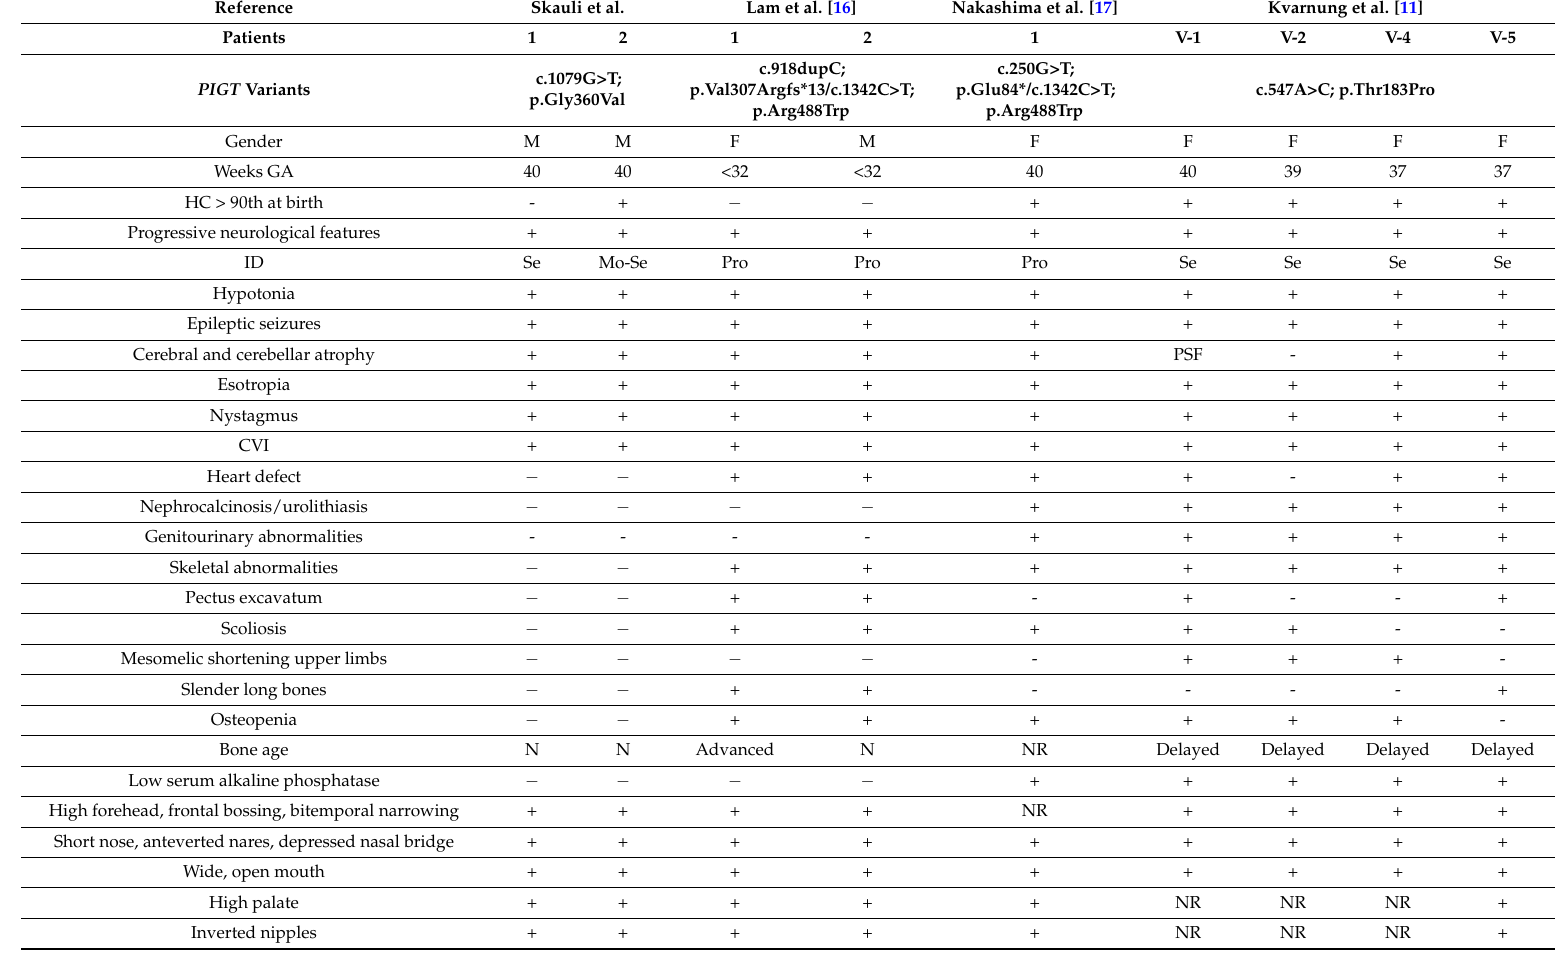
Table 1. Summary of the main clinical features in the patients with Multiple Congenital Anomalies-Hypotonia Seizures Syndrome 3 (MCAHS3) reported to date. +, clinical feature present; − , clinical feature absent. Abbreviations: CVI, cortical visual impairment; ID, intellectual disability; F, female; GA, gestational age; HC,